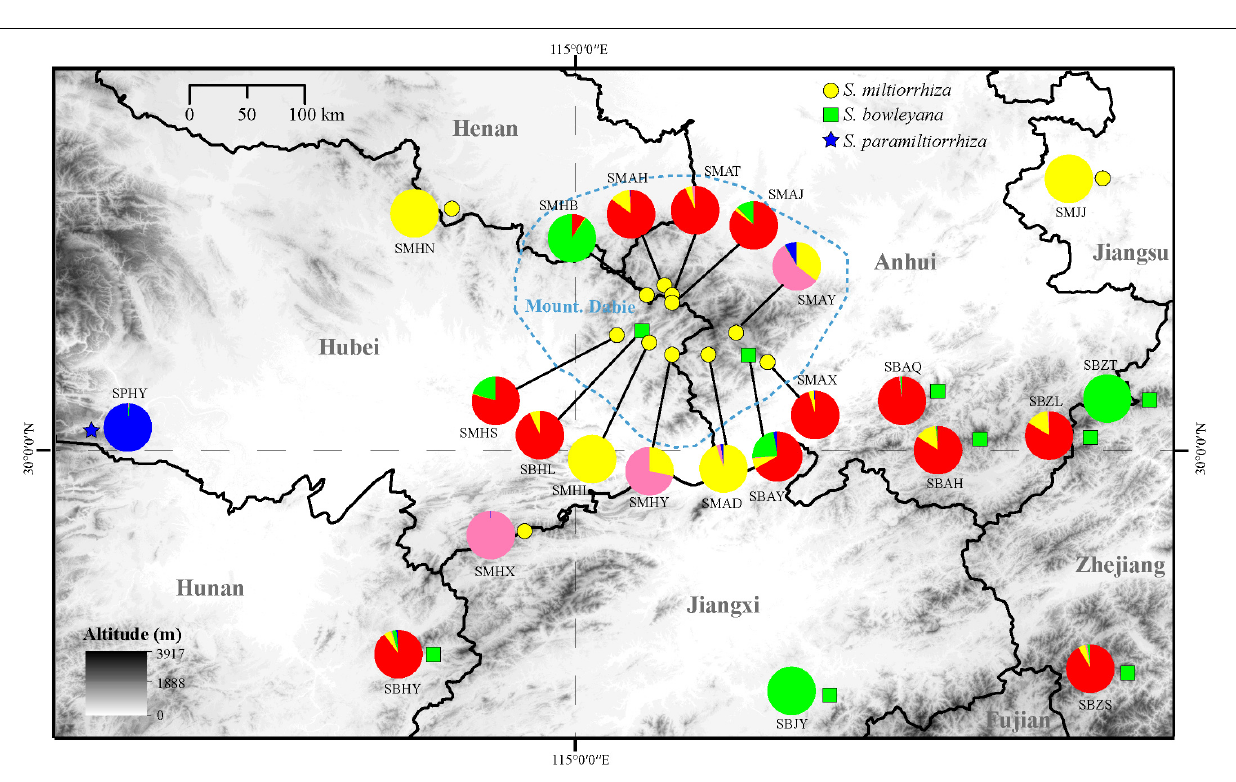
FIGURE 5 | Distribution of the clusters recovered in the Admixture analysis ( K = 5). The yellow circle, green box and blue five-pointed star represent location of sampled populations of S. miltiorrhiza , S. bowleyana , and S. paramiltiorrhiza , respectively. The blue circled area indicates range of Dabie Mountain. Population codes correspond to those in Supplementary Table 1